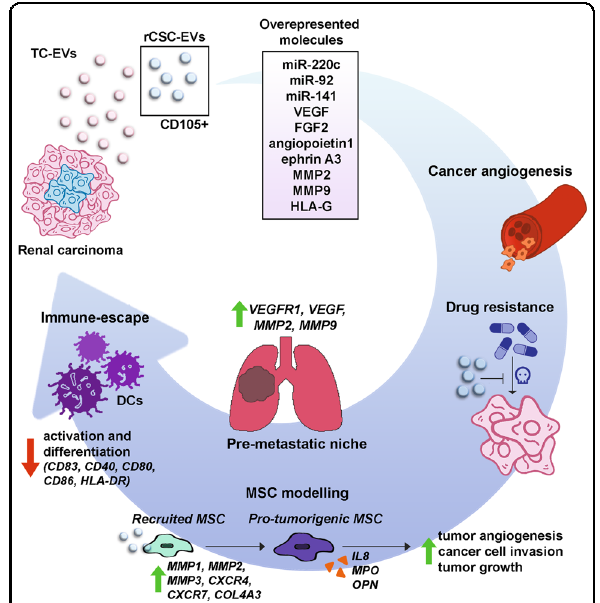
Fig. 1 Role of rCSC-EVs in RCC. Renal carcinoma contains tumoral cells (TC) that are CD105-negative and cancer stem cells (rCSCs) that are CD105-positive. Renal cancer stem cells that are CD105- positive release EVs (rCSC-EVs) that are able to promote tumor growth. There are more than 24 upregulated miRNAs, including miR- 200c miR-92 and miR-141, in CSC-EVs compared to tumoral cell- derived EVs (TC-EVs). Unlike TC-EVs, CSC-EVs carry several mRNAs of proangiogenic genes, such as VEGF, fi broblast growth factor 2 (FGF2), angiopoietin 1, ephrin A3, MMP2 and MMP9. Additionally, HLA-G protein was enriched in rCSC-EVs compared to that in TC-EVs. Moreover, rCSC-EVs support cancer development by several mechanisms. These vesicles were shown to promote tumor angiogenesis in vitro and in vivo and to promote apoptosis resistance following treatment with anticancer drug doxorubicin. Moreover, rCSC-EVs were proven to favor lung premetastatic niche formation through the upregulation of VEGFR1, VEGF, MMP2 and MMP9 in target tissue. In addition, rCSC-EVs can promote MSC migration inducing the upregulation of genes, such as MMP1, MMP3, CXCR4, MMP2, COL4A3 and CXCR7. MSCs stimulated with rCSC-EVs released IL-8, myeloperoxidase (MPO) and osteopontin (OPN) at higher concentrations, promoted cancer angiogenesis and tumor cell migration and increased tumor development in vivo. Finally, rCSC-EVs were shown to mediate cancer immunosuppression by reducing dendritic cell (DC) differentiation and activation. In particular, rCSC-EVs contained higher levels of HLA-G compared to TC-EVs and decreased the expression of activation markers CD83 and CD40, costimulatory molecules CD80 and CD86, and the antigen-presenting molecule HLA-DR in